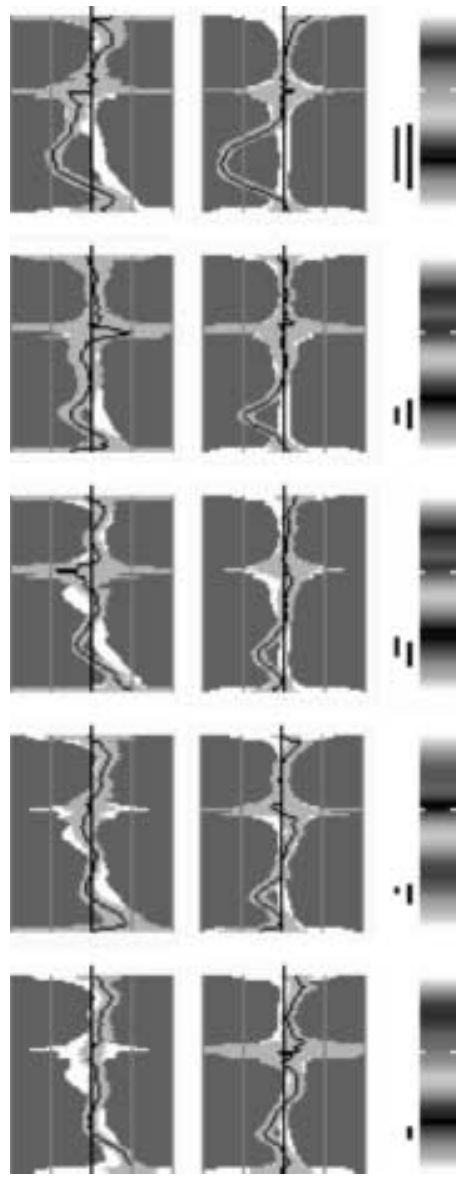
Fig. 1. Chromosome 11 from each analysis of the five cases of leukemia. The left column represents HR-CGH using DOP-PCR am- plified DNA, and the right column represents HR-CGH using unam- plified DNA. The mean ratio profile is shown in black along with the 99.5% confidence interval superimposed on the standard reference interval shown in white. The vertical lines represent the ratio values 0.5, 0.75, 1.0 (black), 1.25, and 1.5. To the right are shown the mean inverted DAPI chromosomes. The bar closest to the mean inverted DAPI chromosome represents the deletion detected by HR-CGH us- ing unamplified DNA [3], and the bar farthest away the deletion de- tected by HR-CGH using DOP-PCR amplified DNA. The cases are from top to bottom: case 1 (14–18 Mbp), case 2 (10–12 Mbp), case 3 (10–12 Mbp), case 4 (7–8 Mbp), case 5 (3